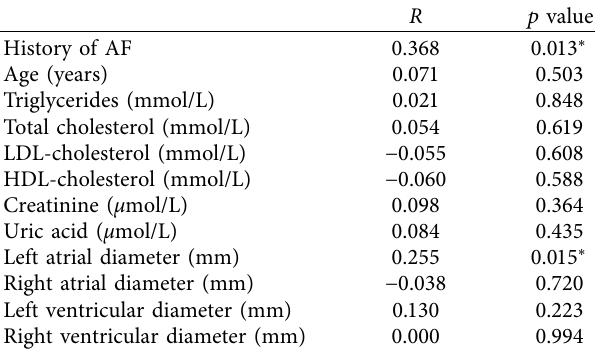
Figure 4: Correlation of the history of AF with LAD. LAD: left atrial diameter. R is Pearson’s correlation